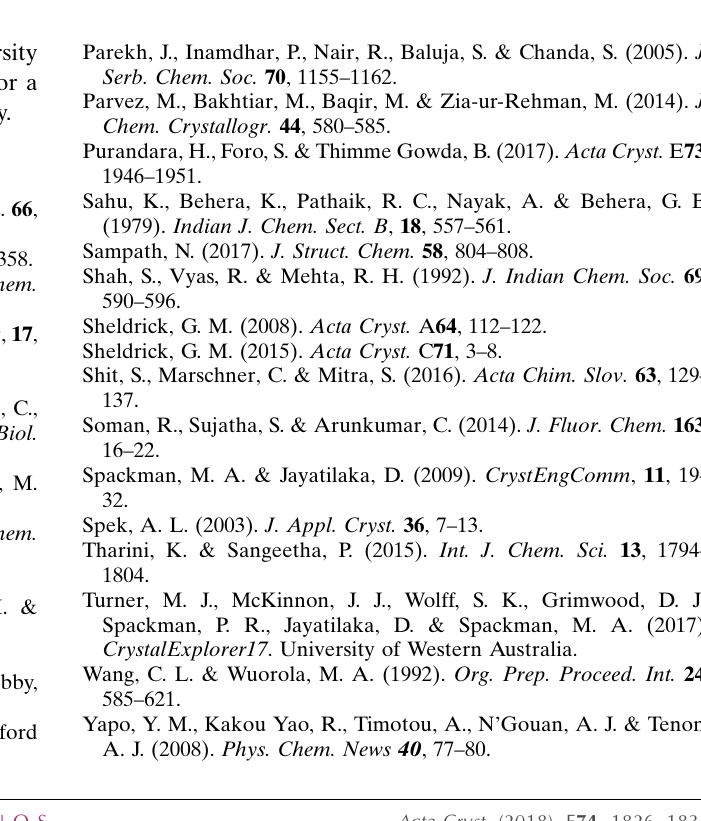
Crystal data Chemical